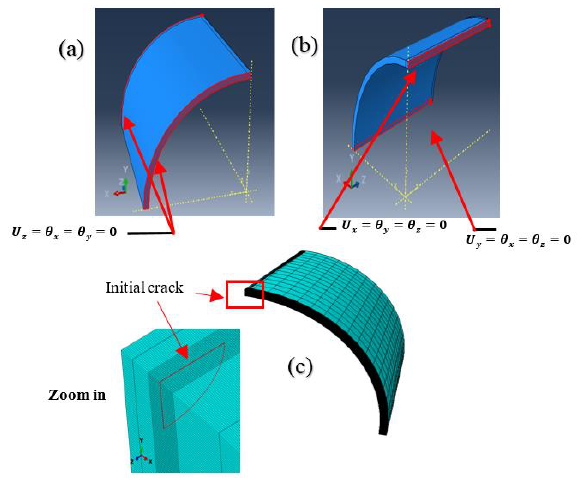
Figure 4. Finite element model and boundary conditions: ( a , b ) Symmetric boundary in the X, Y, and Z direction, and ( c ) mesh of the quart model using extended finite element method (XFEM).